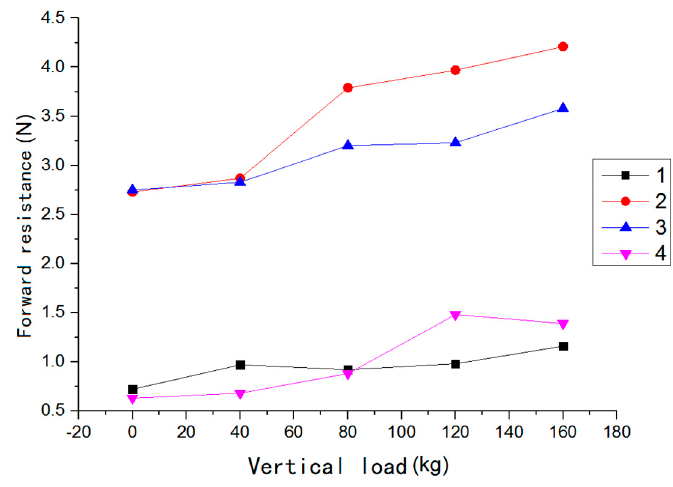
Figure 17. Relationship between forward resistance and vertical load.